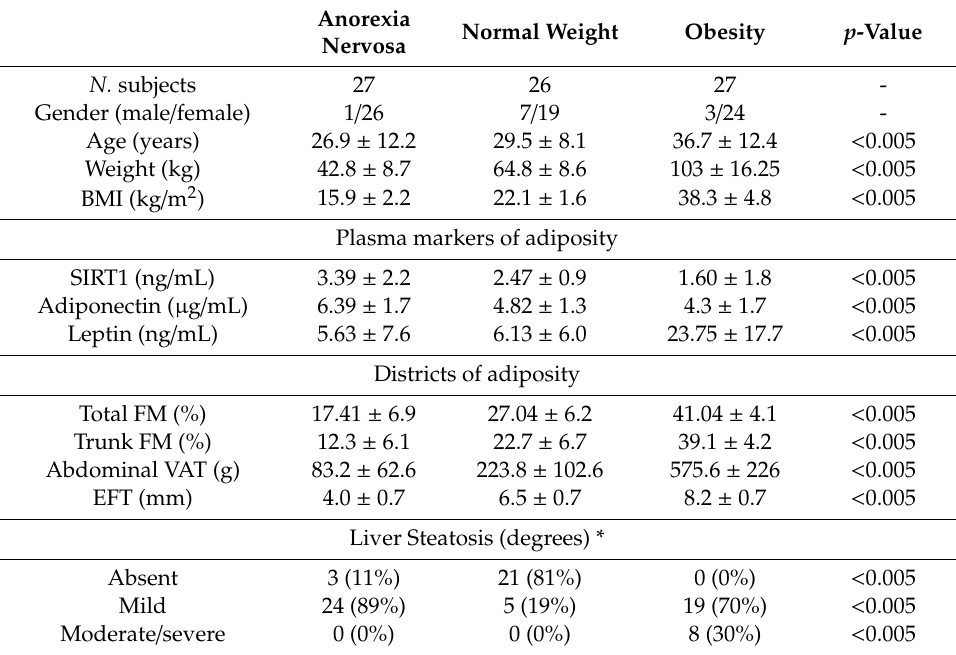
Table 1. Characteristics of the study